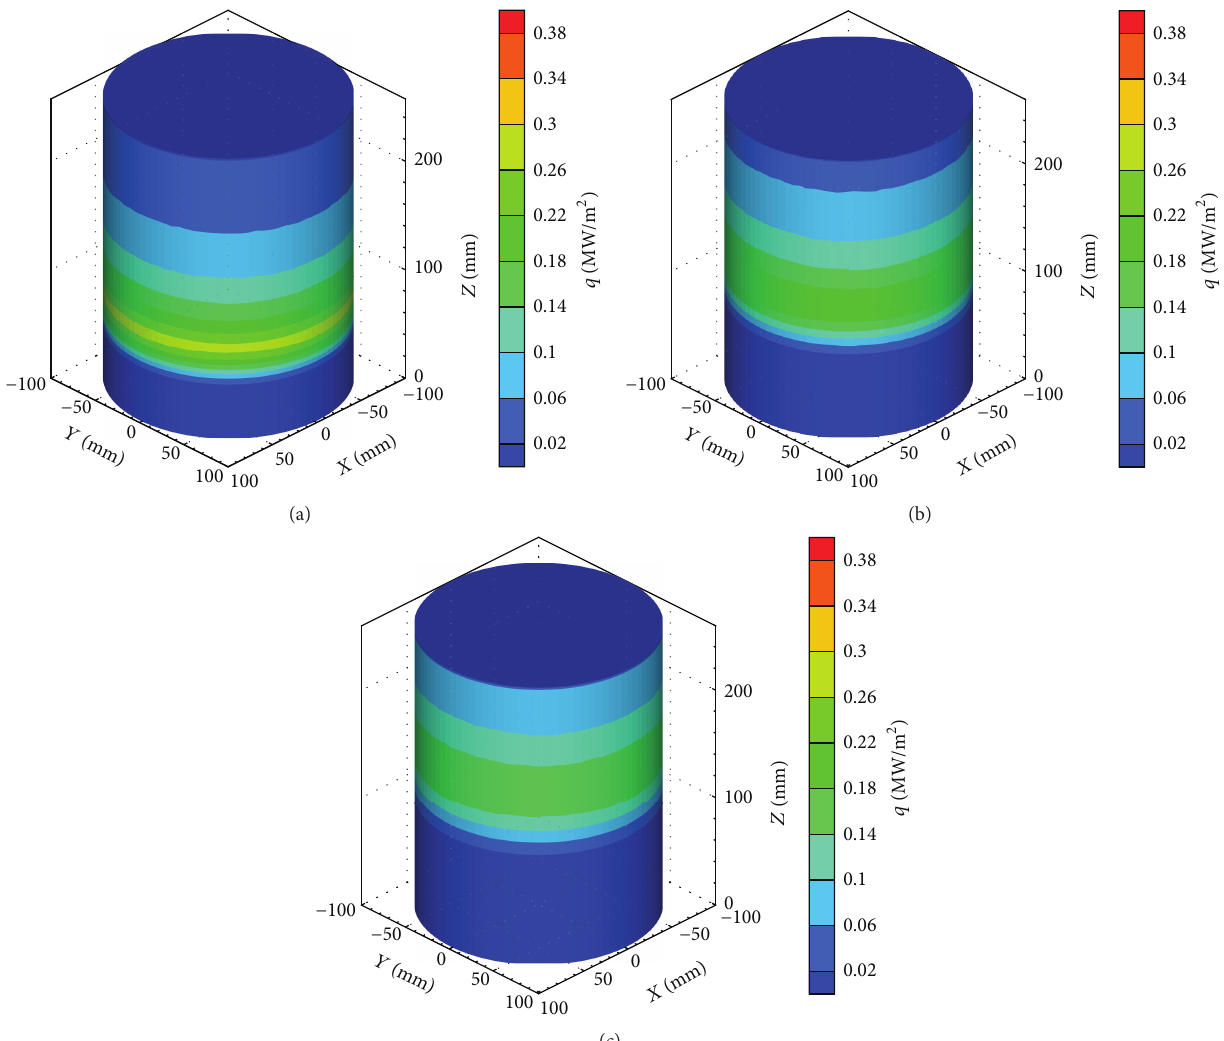
Figure 2: Radiation flux distribution in the receiver with different focal lengths: (a) 2500 mm; (b) 3250 mm; (c) 4000 mm.